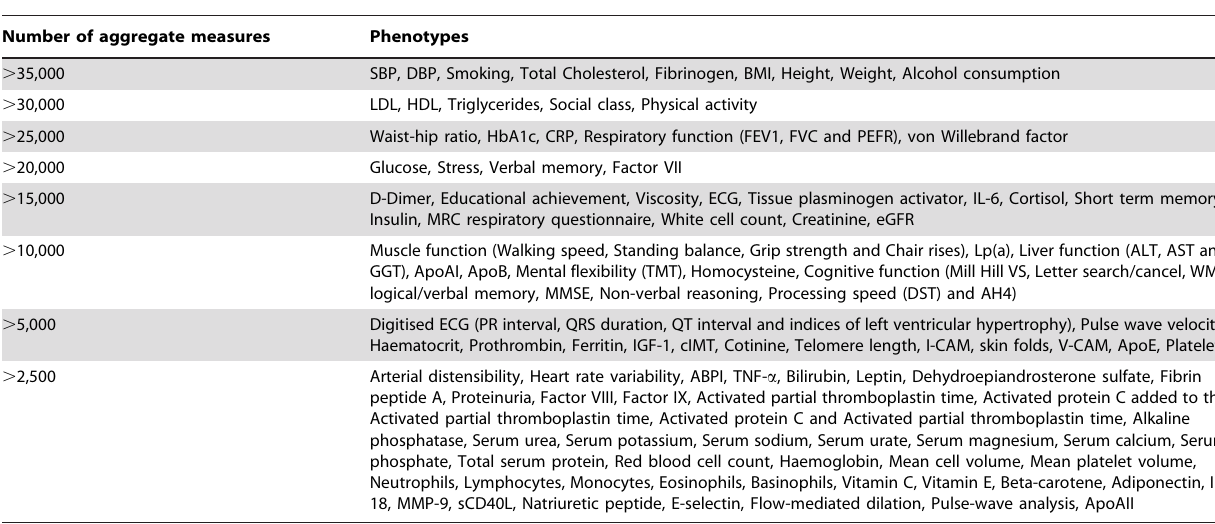
Table 2. Measures available in the UCLEB